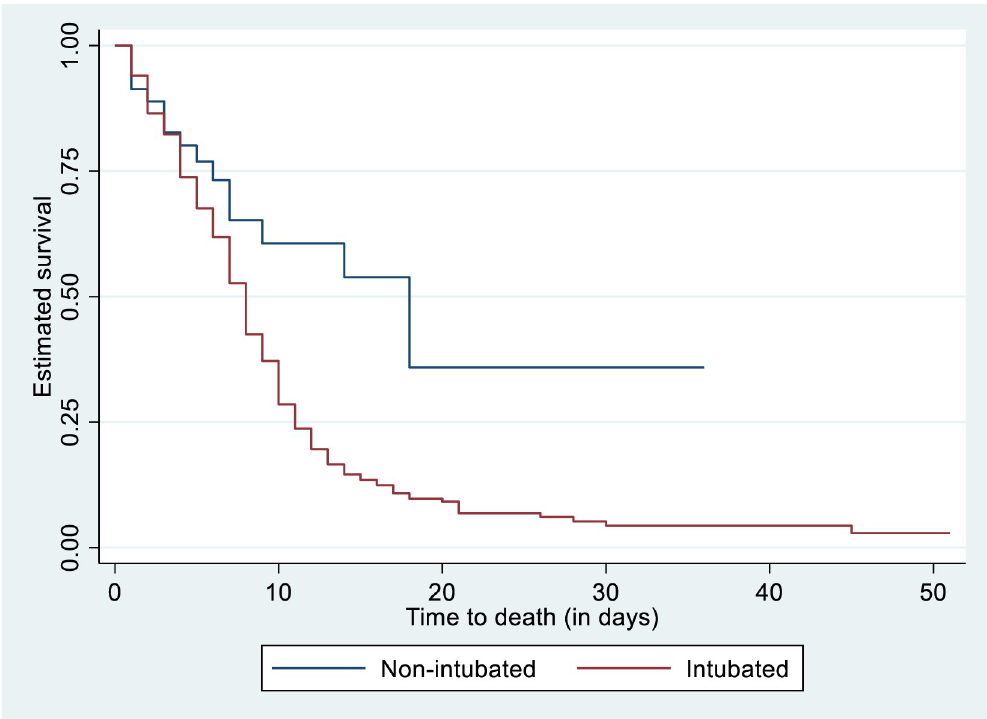
Fig 2. Kaplan-Meier product limit estimates of survival among intubated and non-intubated COVID-19 patients admitted to ICU.